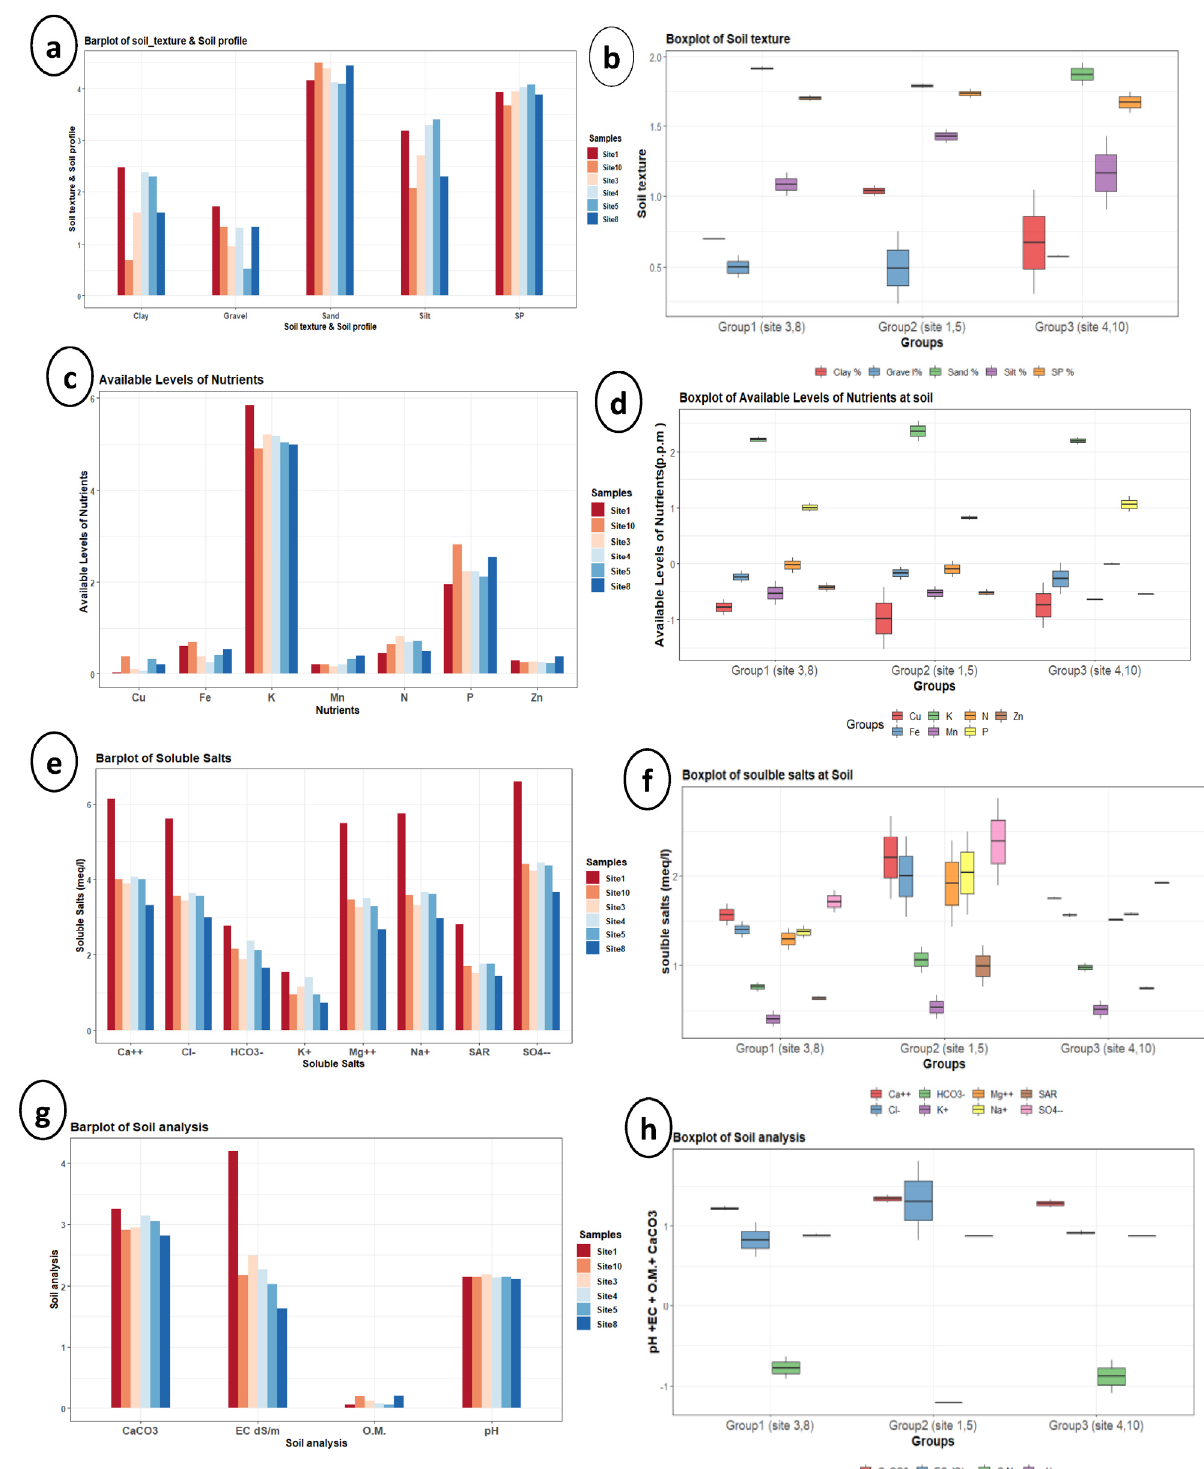
Figure 7. Bar plots and boxplots for soil analysis per site and for groups, respectively: ( a , b ) soil texture and profile, ( c , d ) nutrient concentrations, ( e , f ) soluble salts concentration, and ( g , h ) CaCO 3 (%), EC (ds/m), organic matter (O.M %), and pH.